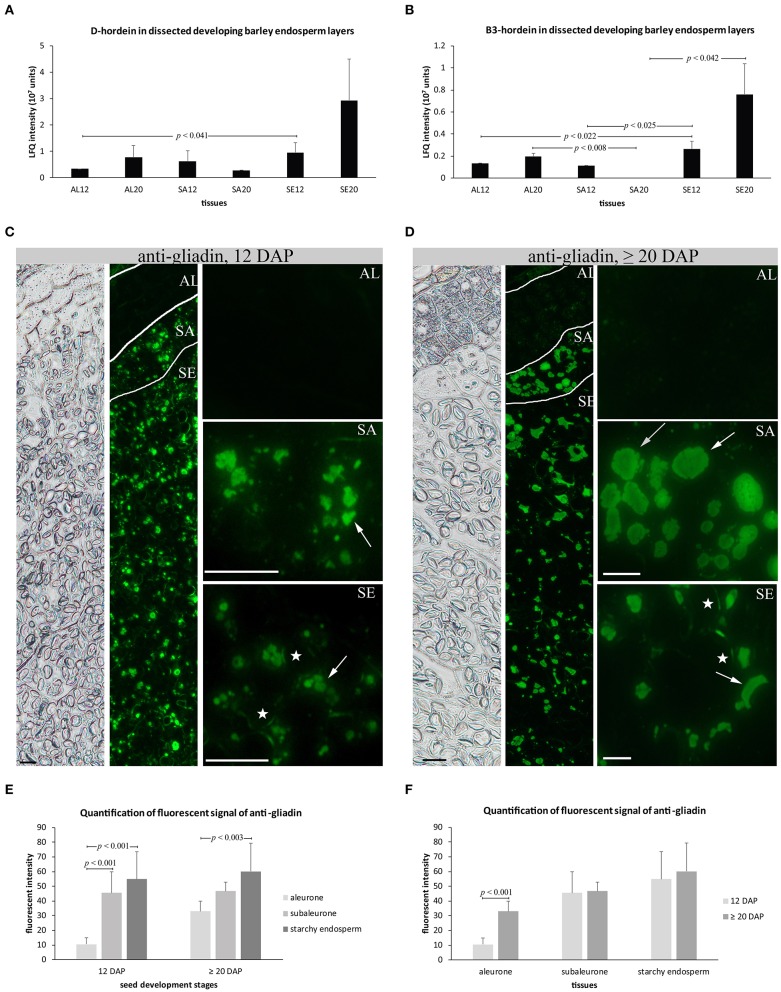
Quantification and subcellular distribution of hordeins at 12 and ≥20 DAP of endosperm development. (A,B) LFQ intensity of D-hordein and B3-hordein of aleurone 12 DAP (AL12) and 20 DAP (AL20), subaleurone 12 DAP (SA12), and ≥20 DAP (SA20) and starchy endosperm at 12 DAP (SE12) and ≥20 DAP (SE20). LFQ intensities of proteins were averaged over three replications. Bars represent standard deviation. For statistical analyses we performed a Student's t-Test (n = 3). The p-values indicate significant quantitative changes of hordeins. (C,D) Immunofluorescence of hordeins with anti-gliadin antibody shows morphological changes of the hordein-positive PBs (indicated by arrows) between 12 DAP (C) and ≥20 DAP (D) in subaleurone (SA) and starchy endosperm (SE). Note the very faint signal in aleurone (AL) at ≥20 DAP. The first two panels show overview pictures of the bright field and the fluorescence channel, respectively. Scale bar = 20 μm. Asterisks indicate starch granule. (E,F) Fluorescent signal quantification of anti-gliadin. Bar plots of the fluorescent intensity of anti-gliadin in all tissues at 12 and ≥20 DAP and in aleurone, subaleurone, and starchy endosperm separately at 12 and ≥20 DAP. Areas (n = 10–13 for 12 DAP; n = 7–11 for ≥20 DAP) were quantified for aleurone (AL), subaleurone (SA), and starchy endosperm (SE) from at least 2 slides with two sections. For statistical analyses we performed a Student's t-test. Bars represent standard deviation. Note the indicated p-values.